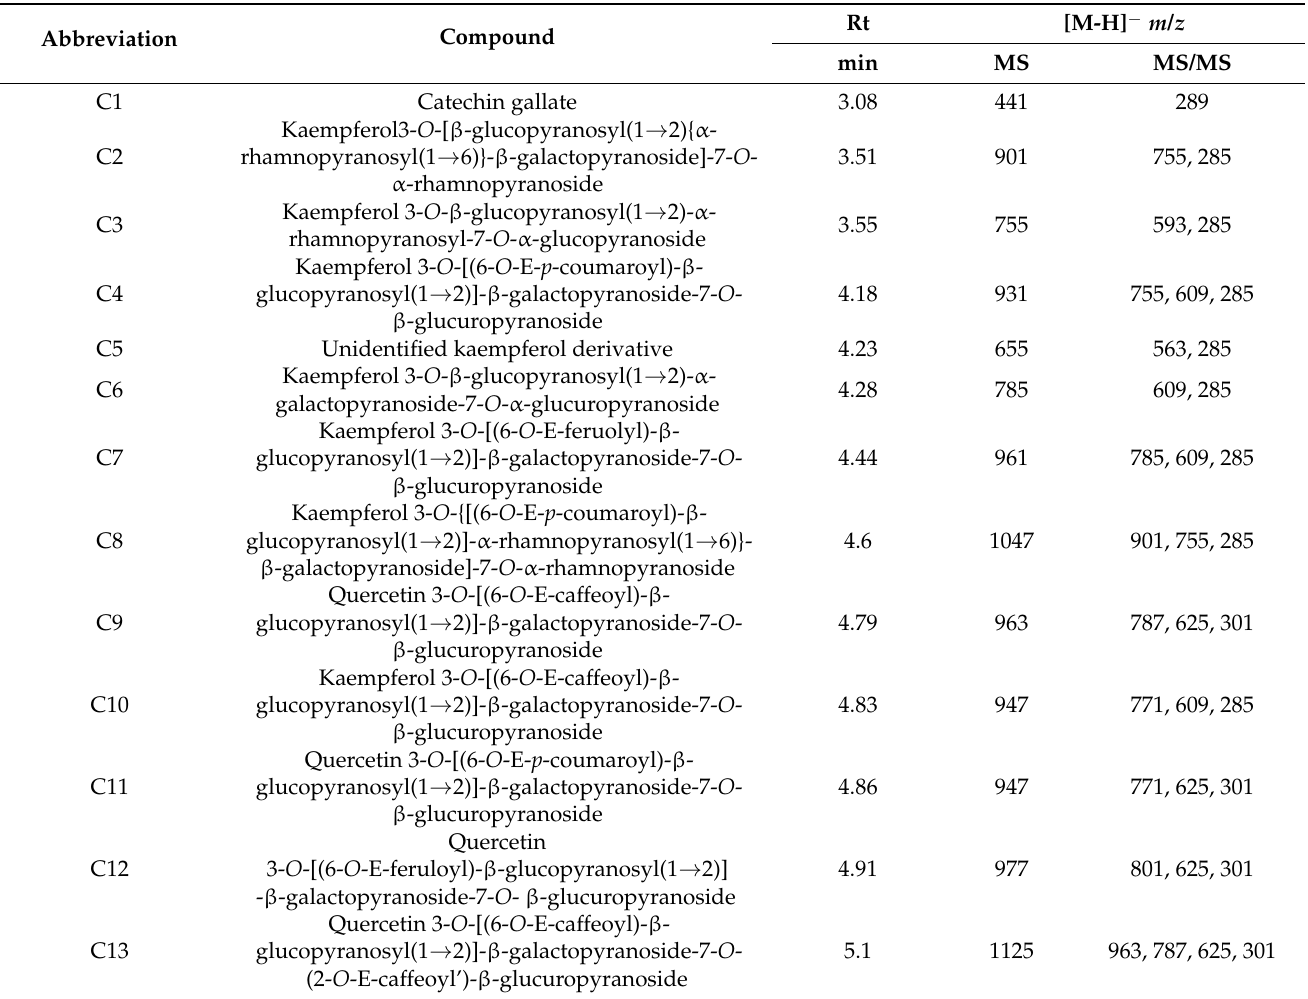
Table 1. Individual phenolic compounds identified by UPLC-PDA-MS/MS in lentils.